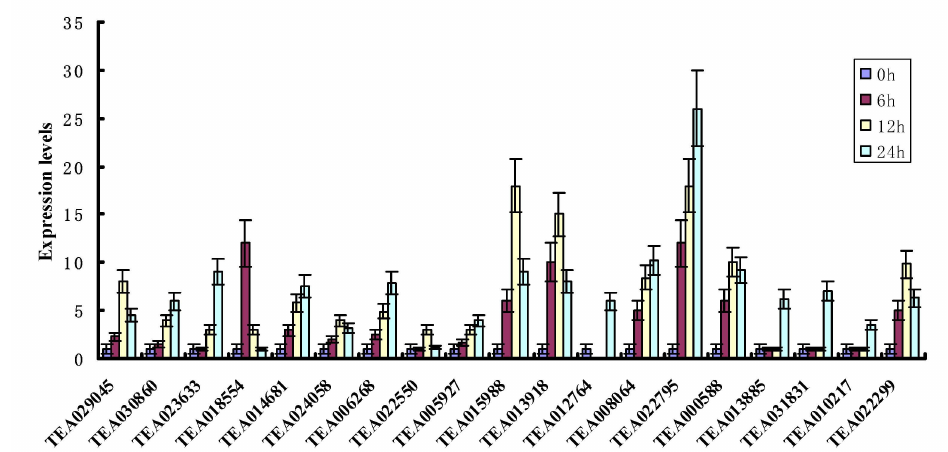
Figure 7. Relative expressions of tea Hsf genes under heat treatment condition. Analyses were carried out by qRT-PCR under heat stress treatment. qRT-PCR data were normalized using tea CsPTB [44] gene and shown relative to 0 h. X-axes showed tea Hsf genes and y-axes are scales of relative expression level (error bars indicate